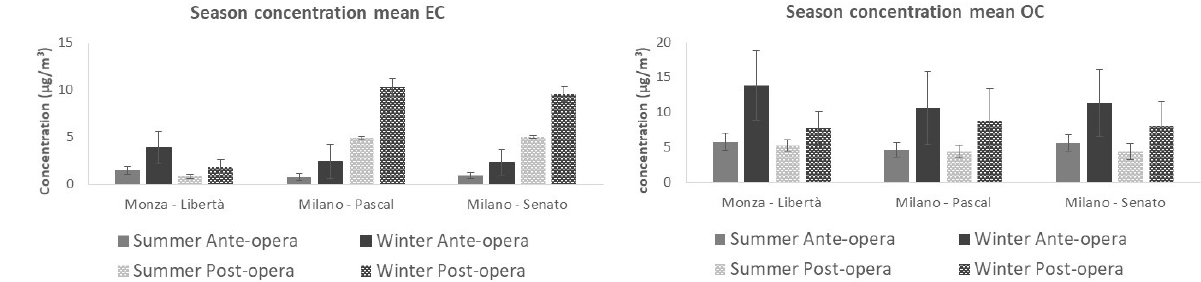
Figure 14: Average concentrations of OC and EC on the two measurement periods "summer" (from 4/5/2017 to 22/5/2017 and from 14/7/2017 to 31/7/2017 in ex-ante operam, from 8/5/ to 21/5/2019 and from 03/7/ to 17/7/2019 in ex-post operam) and "winter" (from 9/11/2017 to 30/11/2017 and from 31/1/2018 to 19/2/2018 in ex-ante operam, from 20/2/ to 26/3/2019 and from 20/7/ to 21/11/2019 in